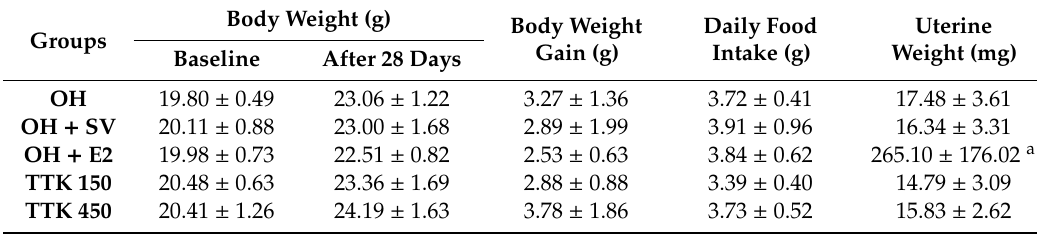
Table 1. Body weight and daily food intake of hind-limb ischemic